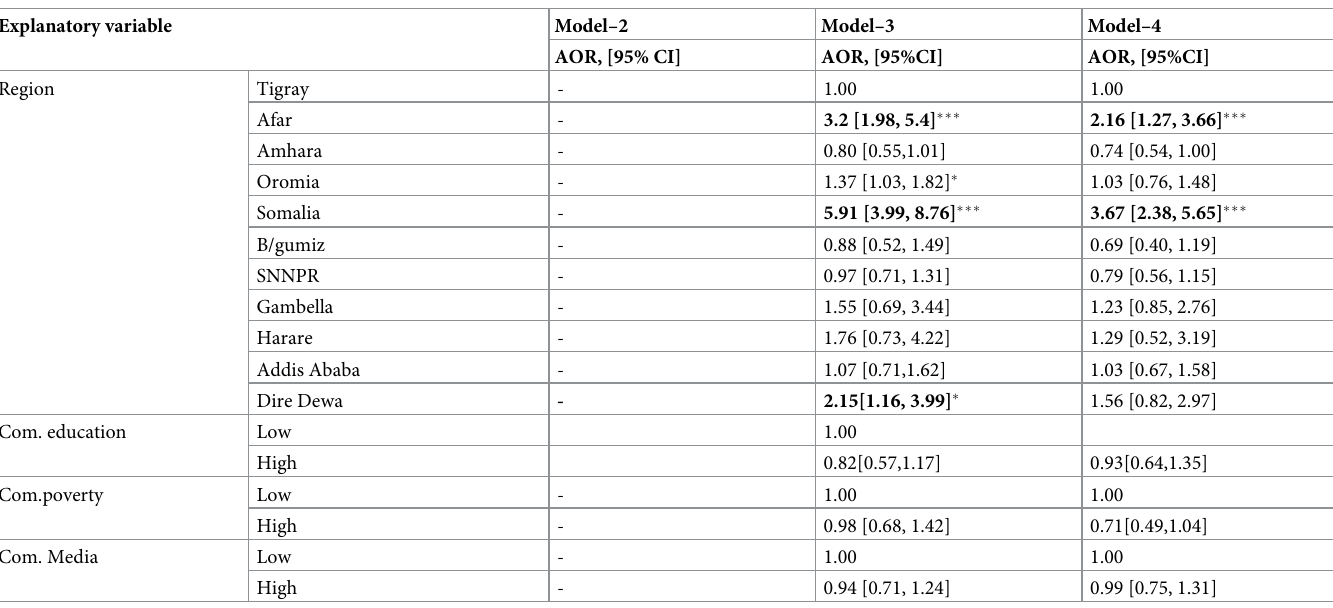
with a Global Moran’s I value of 0.38 (p 0.001). The Z-score of 23.35 indicated that there is less than 1% likelihood that this clustered pattern could result from random chance “Fig 5”. The peak distance with statistically significant z-scores on which spatial processes promoting clus- tering are most pronounced indicated at 151.4 Km; 20.82(distances; Z-score) and 195.8Km; 21.25 (distances; Z-score) “Fig 6”. Hot and cold spot analysis. The figure below showed that, the more intense clustering of high (hot spot) proportion anemia among reproductive age women which represent by the red dots. It was clustered at the Somali, Dire Dewa, and Afar regions of Ethiopia. Whereas, Amhara, SNNPR, and Tigray regions of Ethiopia were fewer risk areas which represents by blue dots “Fig